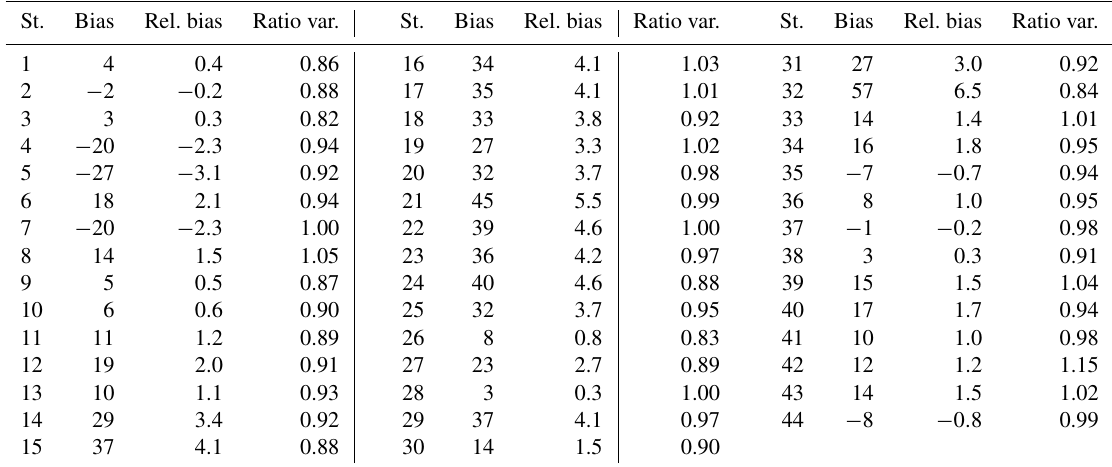
Table 6. Bias (inWm − 2 ) , relative bias (in %), and ratio of variances for G at each station.